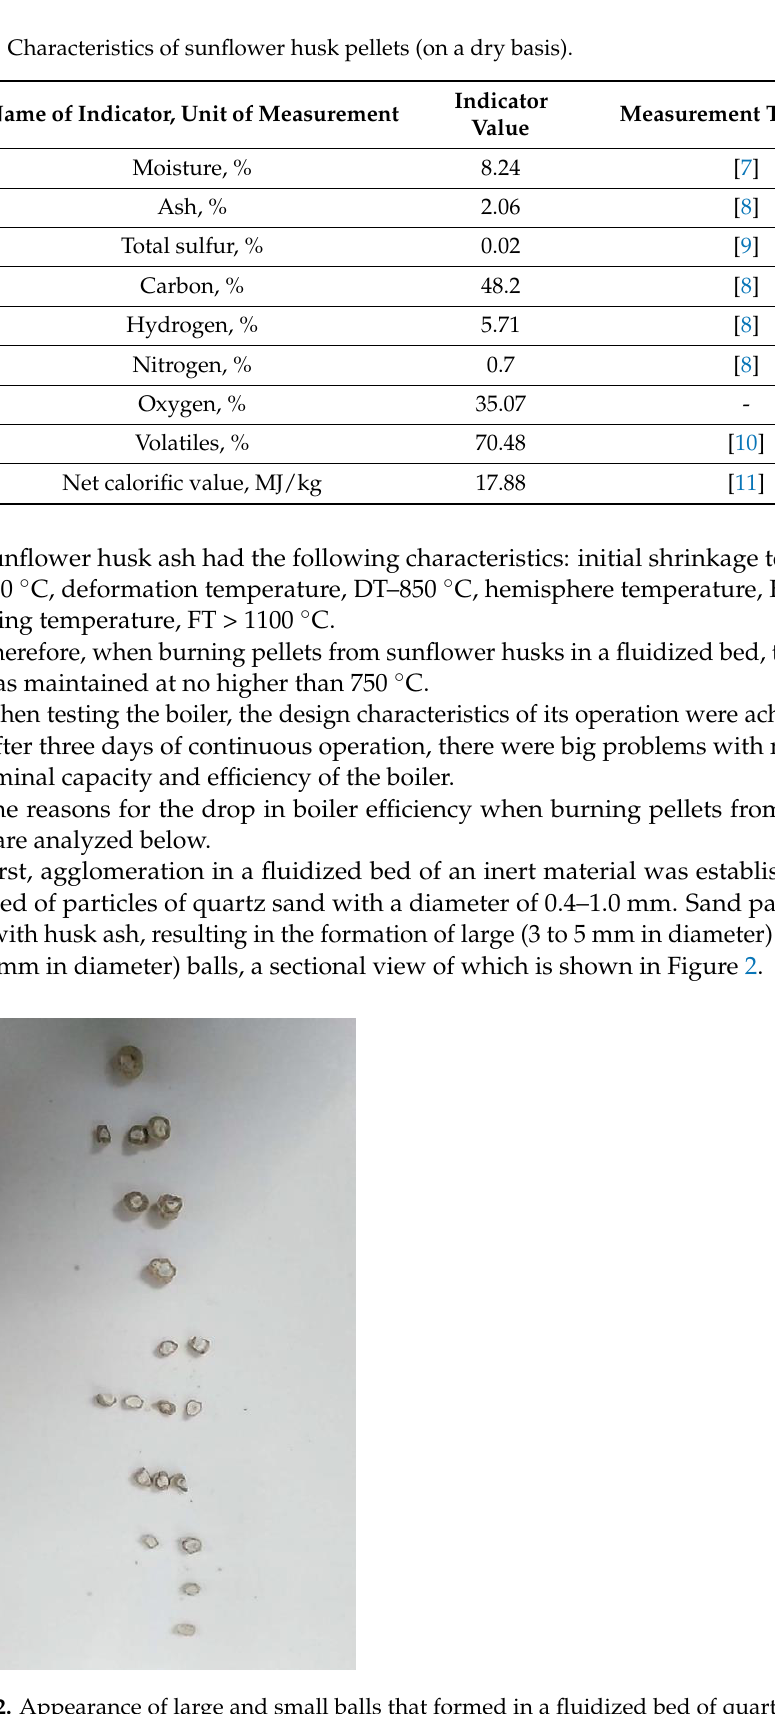
Figure 2. Appearance of large and small balls that formed in a fluidized bed of quartz sand when pellets from sunflower husks were burned in it.